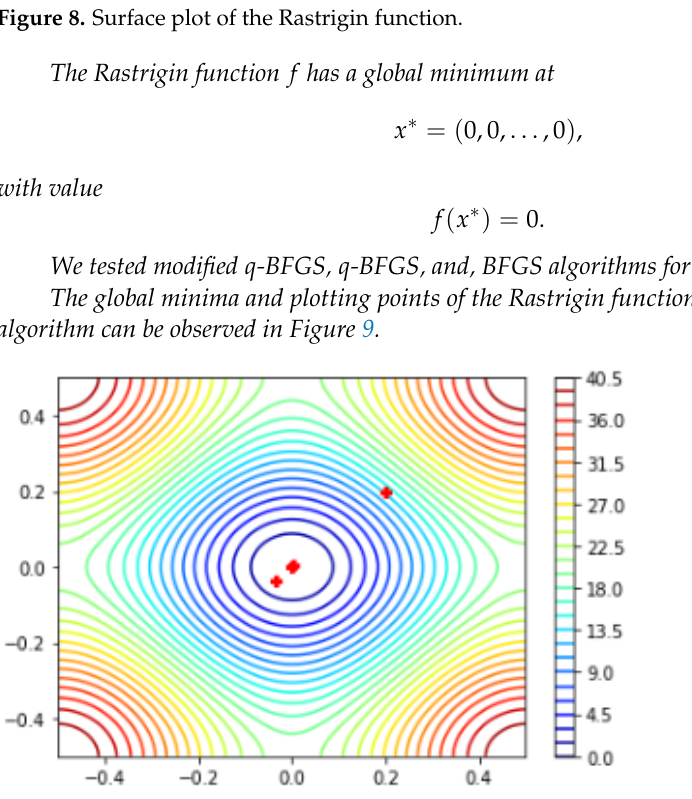
Figure 9. Global minima of the Rastrigin function using the modified q -BFGS